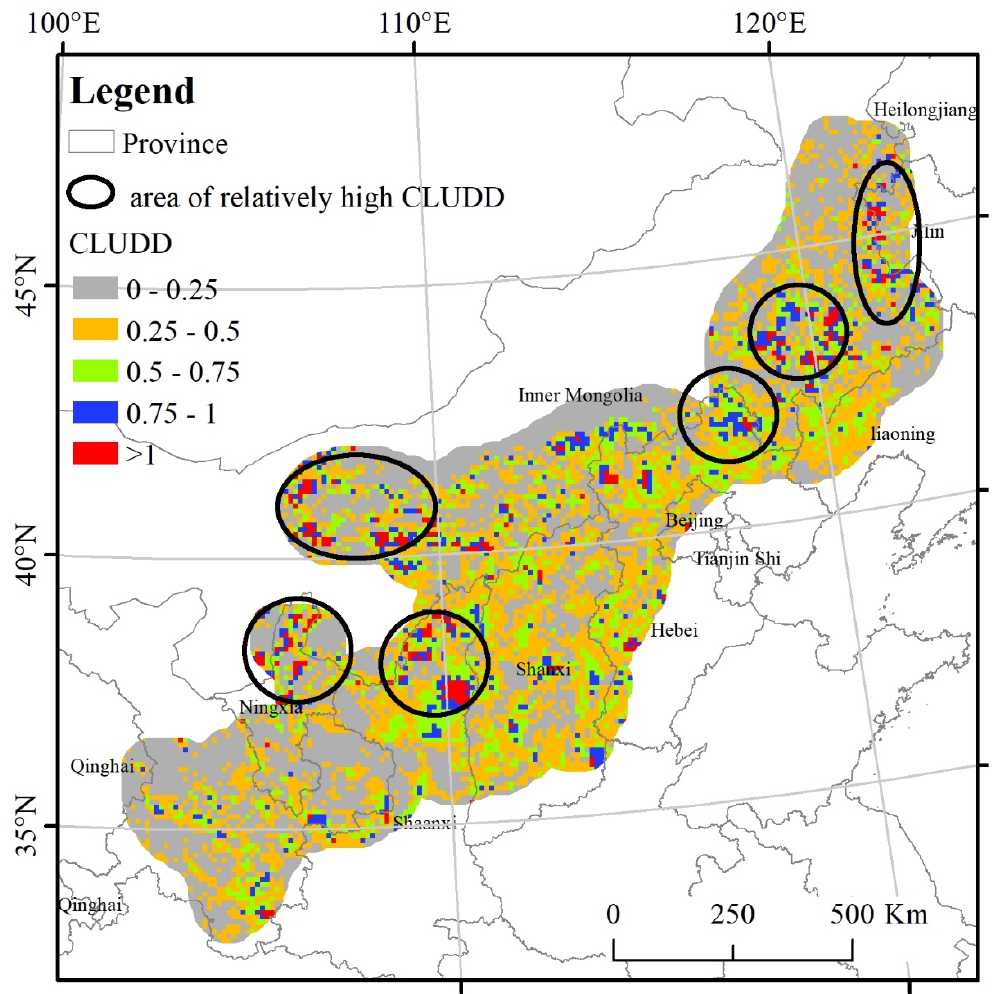
Figure 7. Map of 1-km fishnet grid of comprehensive land use dynamic degree (CLUDD).